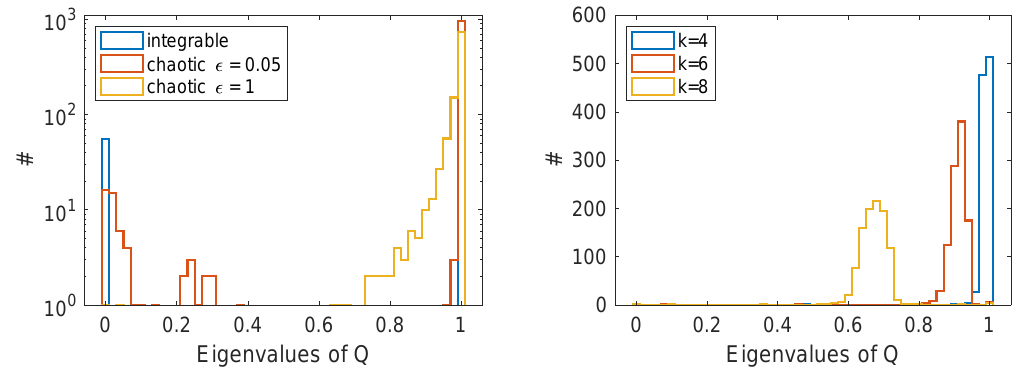
Figure 2: Histograms of the Q -eigenvalues for N = 20 for the integrable (the free (4.3) and interacting models (4.12) display the same histograms) and quartic chaotic deformations (4.13). Left: Histograms for an integrable deformation with ε = 1 and two chaotic deformations with ε = 0.05 and ε = 1 at k = 4. Right: Histograms for chaotic deformations with ε = 5 for different values of the locality threshold k